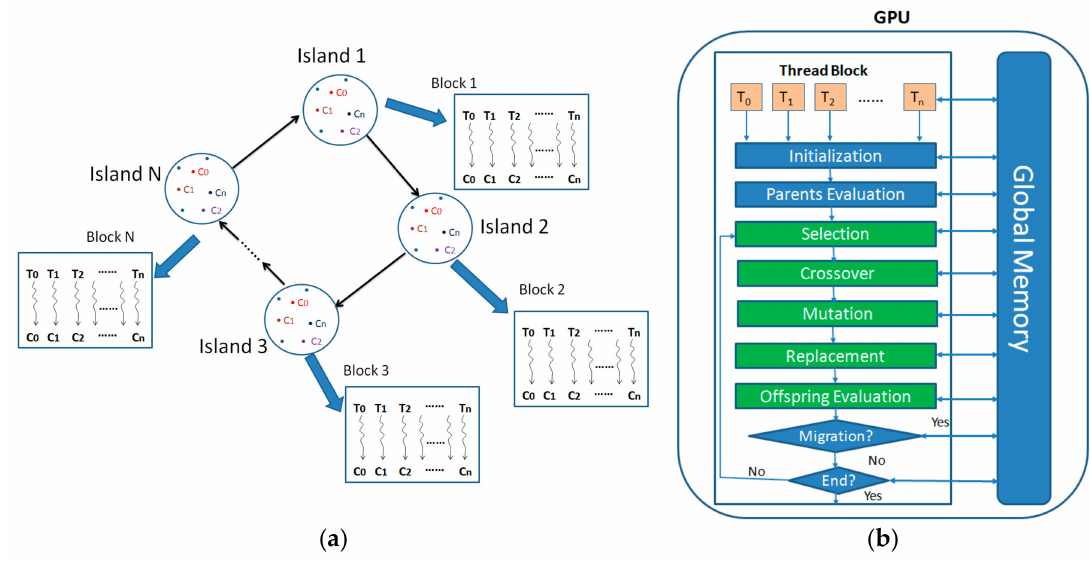
Figure 3. The structure of our parallel IMGA on GPU. ( a ) Description of the main implementation structure. ( b ) Implementation of one particular island on